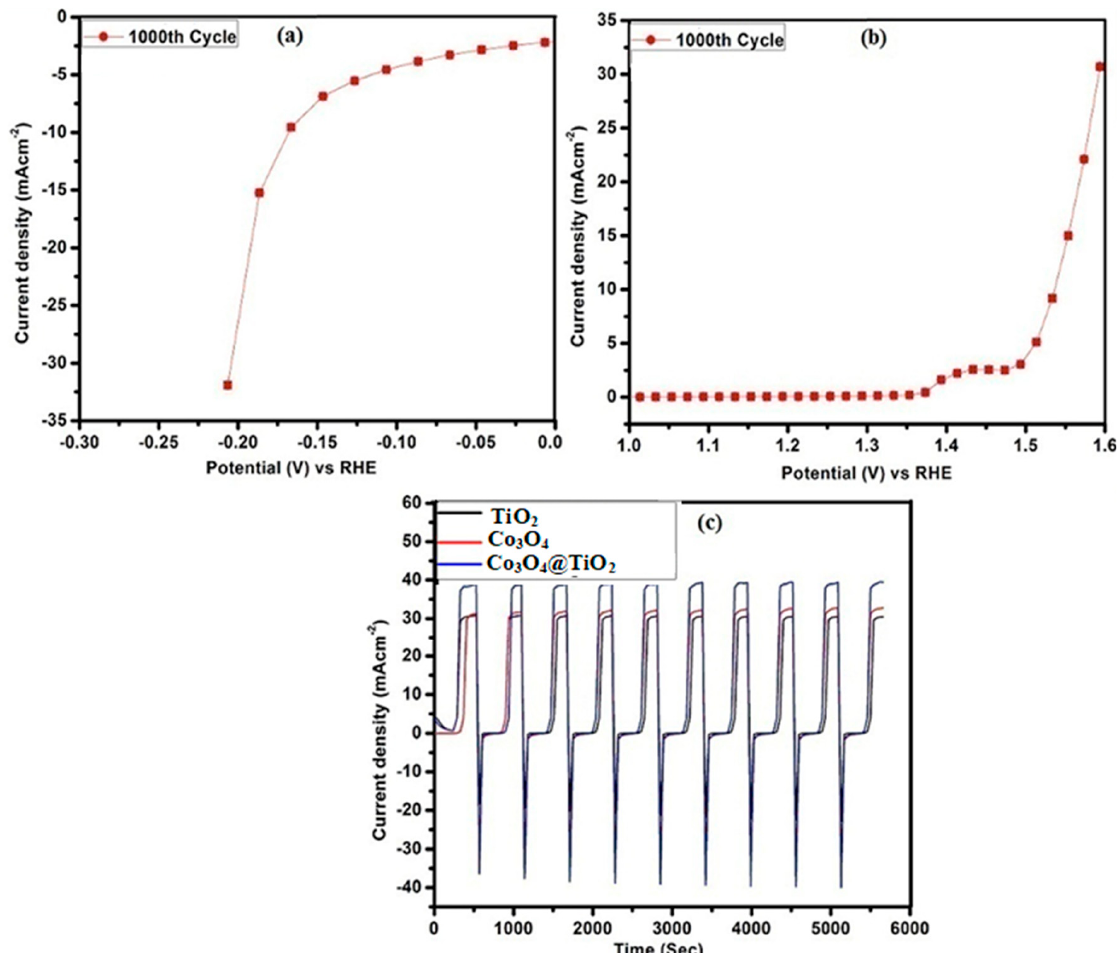
Figure 5. Stability studies. ( a , b ) 1st and 1000th LSV cycle, respectively, and ( c ) chronoamperometry of Co 3 O 4 @TiO 2 composite at 1.5 V for 6000 s.